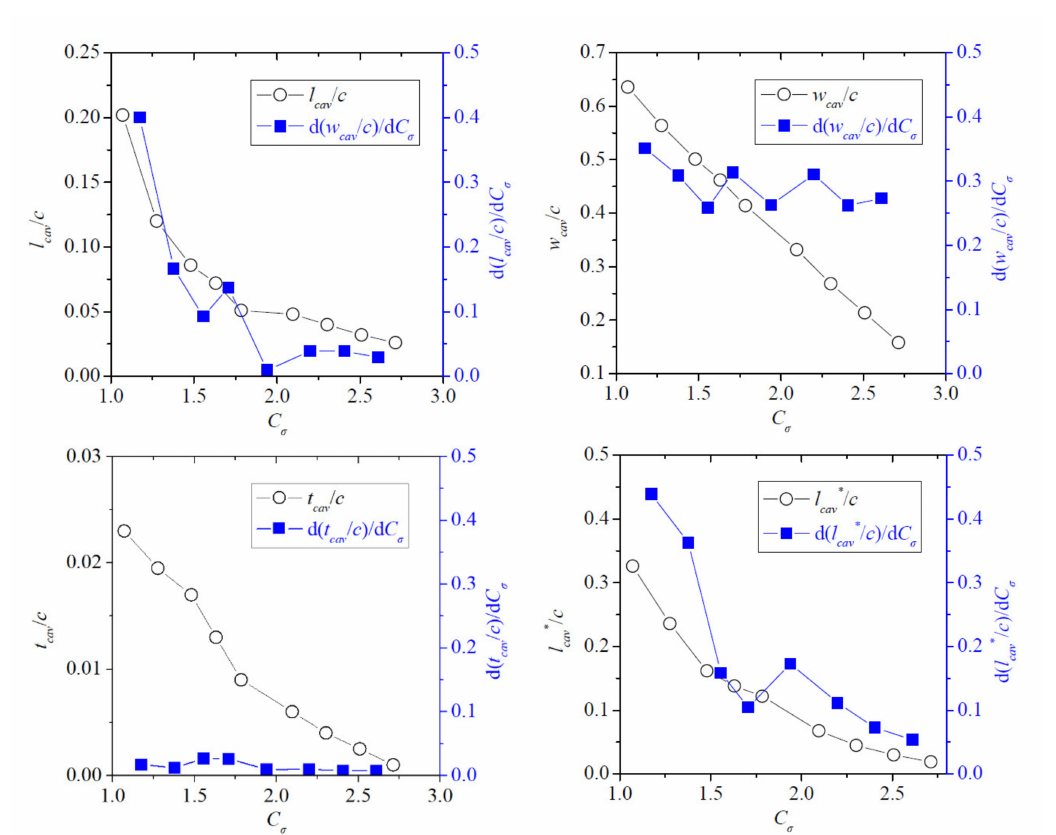
Figure 12. Variation of the length, width and thickness of cavitation bubble on mid-span plane and foil upper surface. For the maximum thickness of cavity on mid-span t cav , the growth rate is relatively stable. The value of d( t cav /c )/d C σ is lower than 0.03. The increasing of t cav /c against C σ is almost linear, except in a small range between 1.784 and 1.480. In this range, a special phenomenon occurs in which a tail can be seen on the profile of cavity. This is because of the backward-jet flow (indicated in Figure 13 as an example), and the cavity becomes much thicker. From C σ = 2.173 to C σ = 1.071, t cav /c increases from about 0.001 to about 0.023. This thickness ( t cav /c = 0.023 at C σ = 1.071) is about 1/4 of the maximum foil thickness.